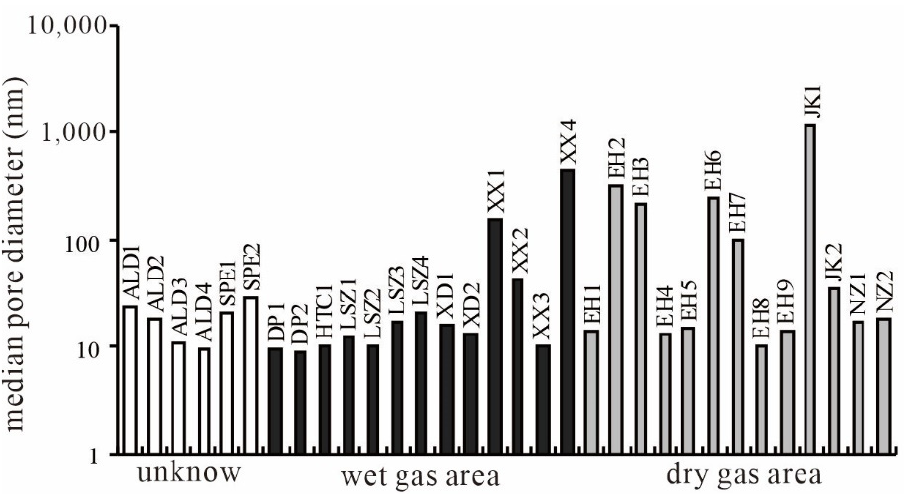
Figure 4. Histogram of total pore-specific surface area.